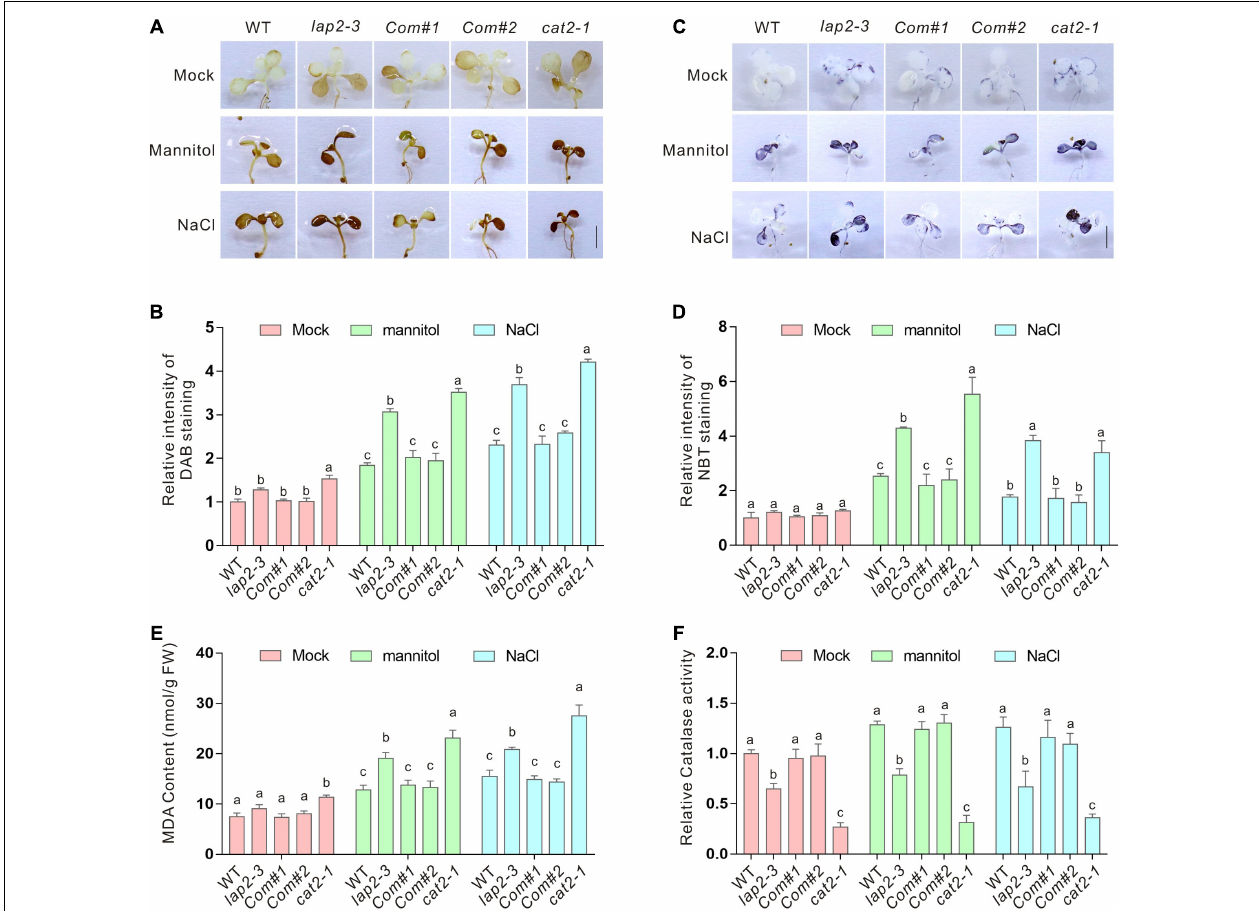
FIGURE 3 | The lap2-3 mutant has higher ROS accumulation and reduced catalase activity. (A) The DAB staining images of the leaves from 5-days-old wild-type, lap2-3 , LAP2 complementation lines and cat2-1 mutant seedlings treated with 250 mM mannitol or 125 mM NaCl for 5 days. Bars = 0.5 cm. (B) The relative DAB staining intensity in panel (A) . The DAB staining intensity of wild-type leaves without treatment was set to 1. (C) The NBT staining images of the leaves from 5-days-old wild-type, lap2-3 , LAP2 complementation lines and cat2-1 mutant seedlings treated with 250 mM mannitol or 125 mM NaCl for 5 days. Bars = 0.5 cm. (D) The relative NBT staining intensity in panel (C) . The NBT staining intensity of wild-type leaves without treatment was set to 1. (E) The MDA content of 5-days-old wild-type, lap2-3 , LAP2 complementation lines and cat2-1 mutant seedlings treated with 250 mM mannitol or 125 mM NaCl for 5 days. (F) The catalase activities in 5-days-old wild-type, lap2-3 , LAP2 complementation lines and cat2-1 mutant seedlings treated with 250 mM mannitol or 125 mM NaCl for 5 days. The catalase activity of the wild type without treatment was set to 1. Data are means ( ± SD) of three biological replicates. Bars with different letters in the same treatment indicate significant differences at p < 0.05, revealed using one-way ANOVA with Tukey’s multiple comparison test.